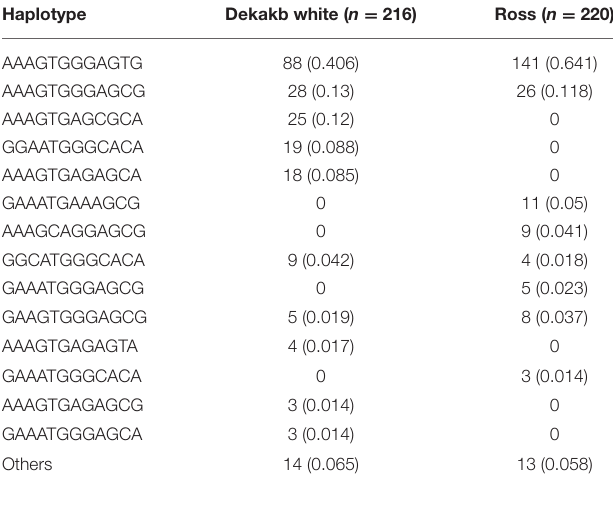
TABLE 3 | Haplotype frequencies of 12 SPRN polymorphisms in Dekalb White and Ross chickens. Haplotype